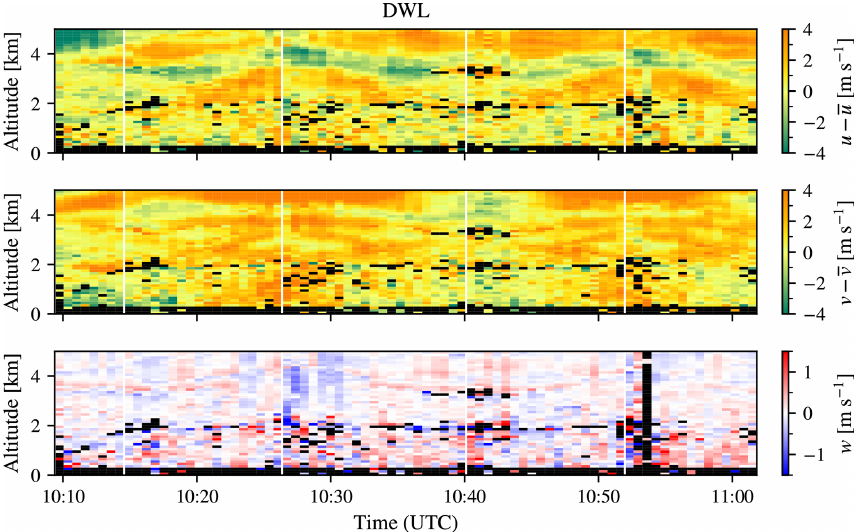
Figure 3. Anomalies of zonal ( u ), meridional ( v ), and vertical ( w ) wind measurements from the DWL, zoomed in on the lowest 5km. Measurements taken on 4 June 2019. Missing values are indicated in black and often correspond to clouds (1–2km altitude). White vertical lines indicate turning points at the ends of each the track.